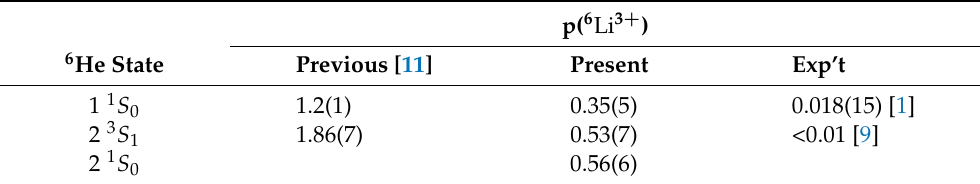
Table 5. Corrected probabilities p( 6 Li k + ) of forming the various charge states of 6 Li k + , k = 1,2,3 following the beta decay of 6 He(1 1 S 0 ) or 6 He(2 3 S 1 ) as initial states. All quantities are expressed